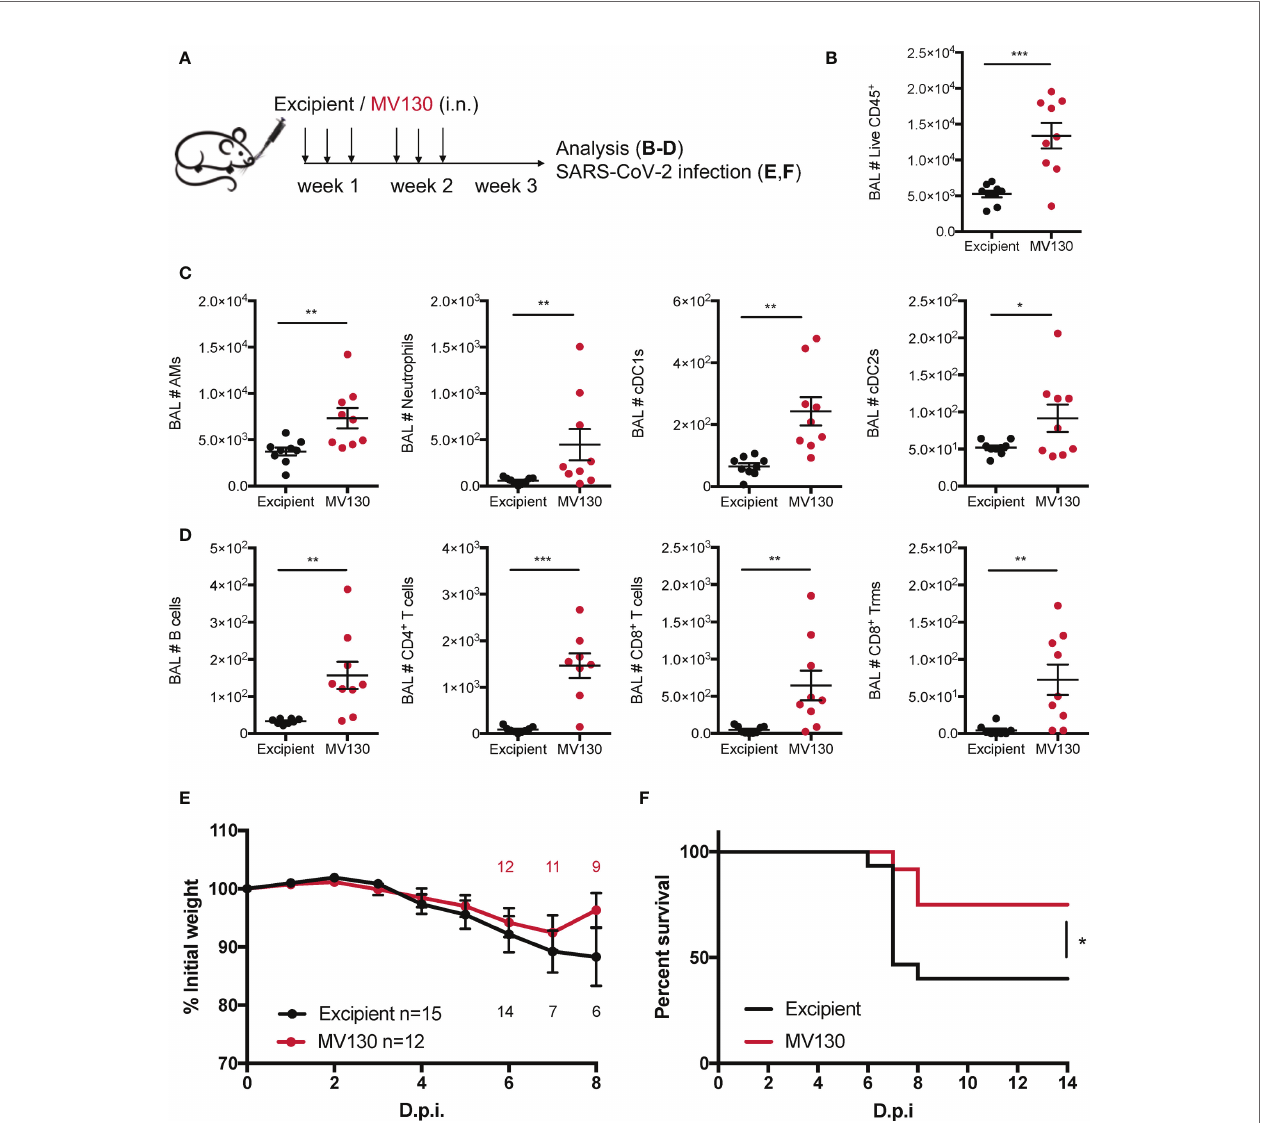
FIGURE 1 | MV130 prophylactic administration protects against SARS-CoV-2 infection. (A) Scheme of immunotherapy administration. Mice were i.n. administered with excipient or MV130 three times per week for 2 weeks. After a resting week, mice were analyzed or infected. (B – D) Bronchoalveolar lavage (BAL) was obtained from excipient and MV130-treated C57BL/6 mice. Quantitative analysis of total live CD45 + cells (B) , different myeloid (C) or lymphoid (D) immune populations identi fi ed by FACS. AMs, alveolar macrophages; cDC1s, type 1 conventional dendritic cells; cDC2s, type 2 conventional dendritic cells. N=2. (E, F) K18-hACE2 mice received excipient or MV130 as indicated in (A) . One week later they were i.n. infected with 10 4 PFU of SARS-CoV-2 (MAD6 strain). Weight (E) and survival (F) were monitored daily. (E) Numbers in the graph indicate remaining alive mice. N=2. (n=15 excipient; n=12 MV130). D.p.i., days post infection. (B – E) Data shown as mean ± SEM. *p < 0.05; **p< 0.01; ***p < 0.001, Student ’ s t test comparing excipient versus MV130. (F) *p < 0.05, Mantel-Cox